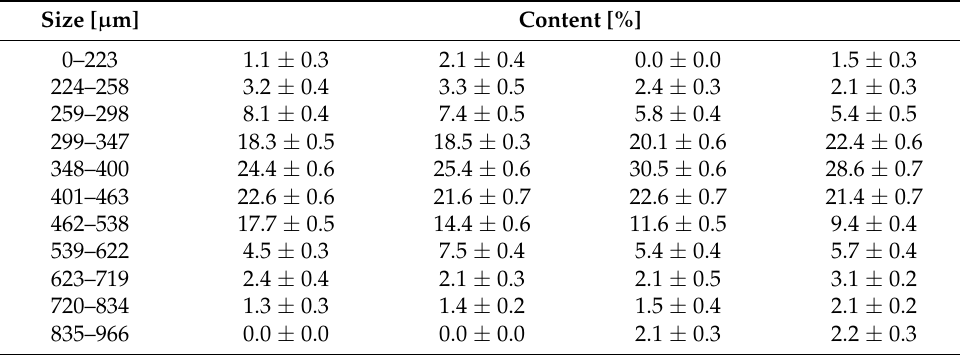
Figure 9. Percentage distribution of cell size in the structure of PUR composites. Table 3. Percentage distribution of cell size.